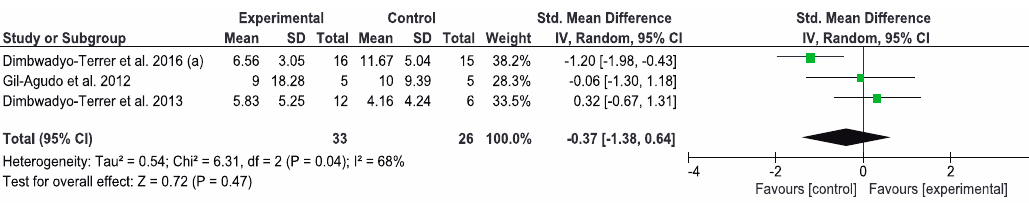
Figure 6. Forest plot for functional performance measured by SCIM self-care subtest. A green block indicates the weight assigned to the study and the horizontal line depicts the confidence interval. A black rhombus shows the overall result.